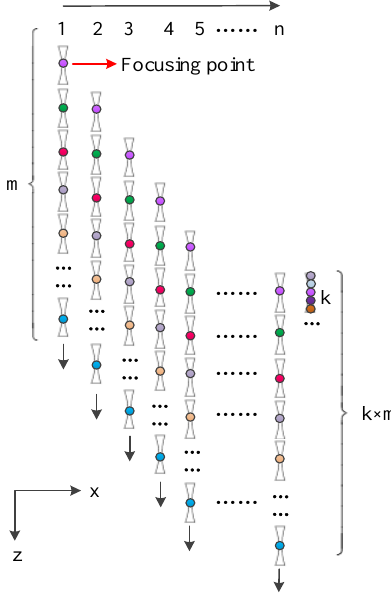
Figure 7. The imaging process of mfMAET-CPS.